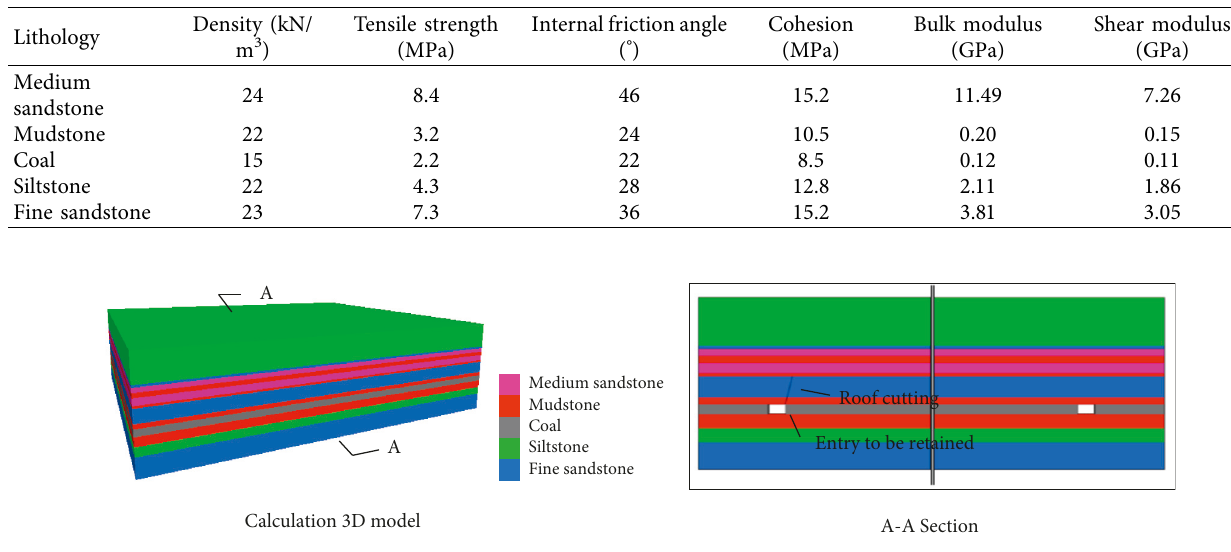
Figure 6: Roadway deformation in Datong mining area. (a) Sidewall deformation. (b) Roof deformation. Table 3: Mechanical parameters of model strata.